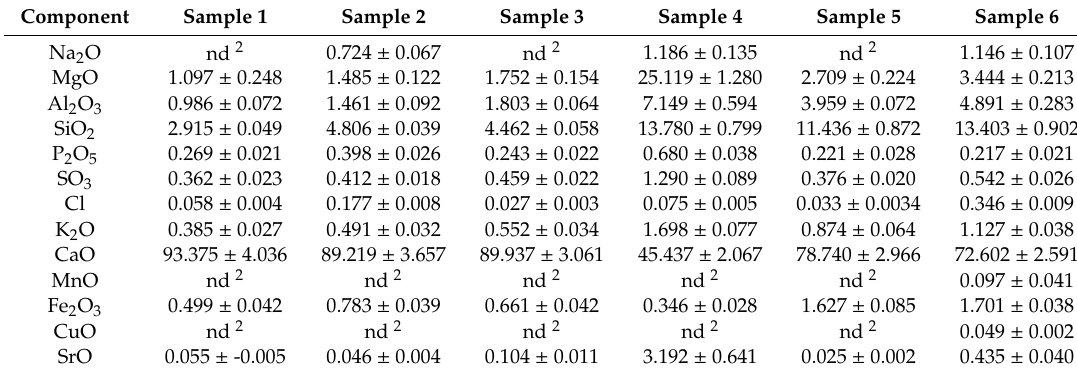
Table 2. Mineral composition of the mosaic fragments 1 determined by WDXRF, expressed in mass% ± S.D.%, normalized to 100%.